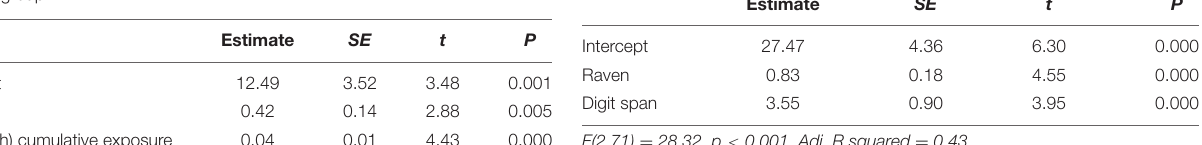
TABLE 3 | The best regression model predicting the productive vocabulary in the bilingual group.